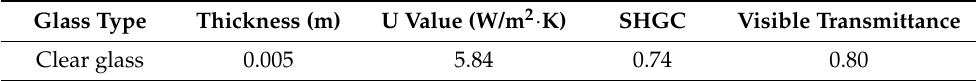
Table 3. Material setting of